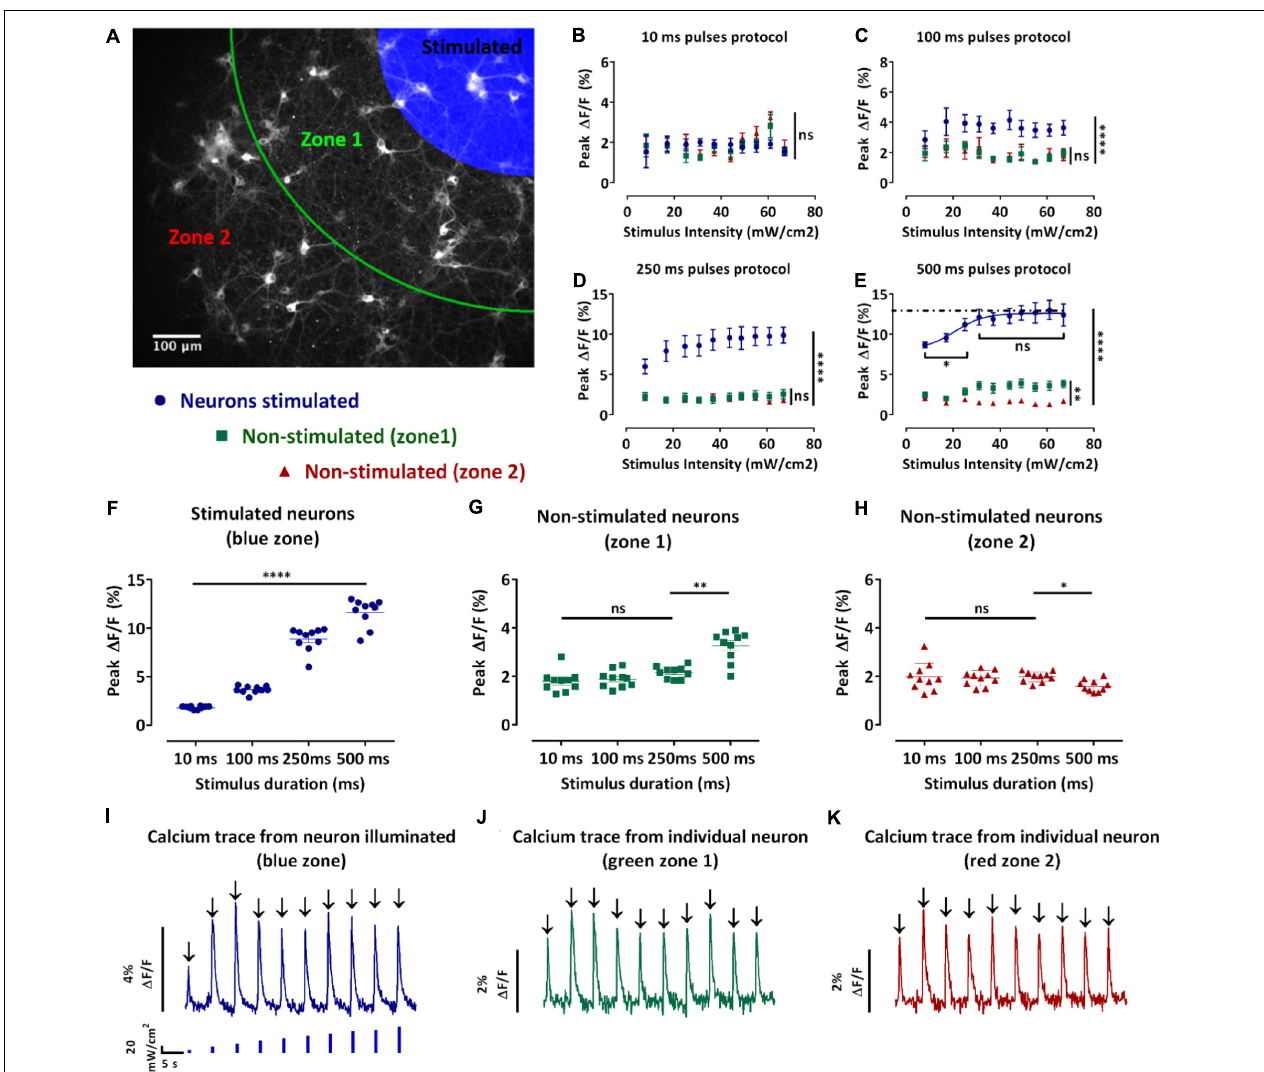
FIGURE 3 | Design and analysis of the spatio-temporal optical stimuli protocols. (A) Map defining the three zones for the spatio-temporal optical stimuli protocols and analysis. Neurons in the blue zone were stimulated, neurons in zone 1 (green) and 2 (red) were not stimulated. (B–E) Average of the peak fluorescence intensities of single-neurons in the same zone ± s.e.m. against the stimulus intensity for the 10 ms (B) , 100 ms (C) , 250 ms (D) , and 500 ms (E) pulses protocols. According to the map in (A) , in blue, average peak fluorescence intensity for the stimulated neurons, in green, non-stimulated neurons in the zone 1 and in red, non-stimulated neurons in the zone 2 ( n = 3 independent cell culture experiments, one-way ANOVA, (B) F (2,27) = 0.4533, P = 0.6403; (C) F (2,27) = 298.8, P < 0.0001; (D) F (2,27) = 301.7, P < 0.0001; (E) two-way ANOVA, effect of the stimulus intensity F (9,370) = 39.65, P < 0.0001 and effect of distance to stimuli (zones) F (2,370) = 9316, P < 0.0001; (B–E) followed by Tukey’s multiple comparisons test: ns=non-significant, ∗ P < 0.05, ∗∗ P < 0.01, ∗∗∗∗ P < 0.0001). (F–H) Pooled peak fluorescence intensities of each defined zone separately ± s.e.m. (F) stimulated neurons, (G) non-stimulated neurons in zone 1, and (H) non-stimulated neurons in zone 2 for stimuli intensities from 0 to 67 mW/cm 2 against the pulse duration. ( n= 3 independent cell culture experiments, two-way ANOVA, (F) effect of the stimulus intensity F (9,520) = 2810, P < 0.01 and effect of the stimulation duration F (3,520) = 296.1, P < 0.0001; (G) effect of the stimulus intensity F (9,520)=0.7990, non-significant and effect of the stimulus duration F (3,520) = 26.21, P < 0.0001; (H) effect of the stimulus intensity F (9,520) = 0.8480, non-significant and effect of the stimulus duration F (3,520) = 2.994, P < 0.05; (F–H) followed by Tukey’s multiple comparisons test: ns=non-significant, ∗ P < 0.05, ∗∗ P < 0.01, ∗∗∗ P < 0.001, ∗∗∗∗ P < 0.0001). (I–K) Typical traces of the fluorescence change of the GECI jRCaMP1b of a single-neuron during the 100 ms pulses protocol of increasing blue stimulation intensities (0 to 67mW/cm 2 ). (I) neuron stimulated; (J) non-stimulated neuron in zone 1 and (K) non-stimulated neuron in zone 2. From these traces we can then extract the peak fluorescence (cid:49) F/F (black arrow).